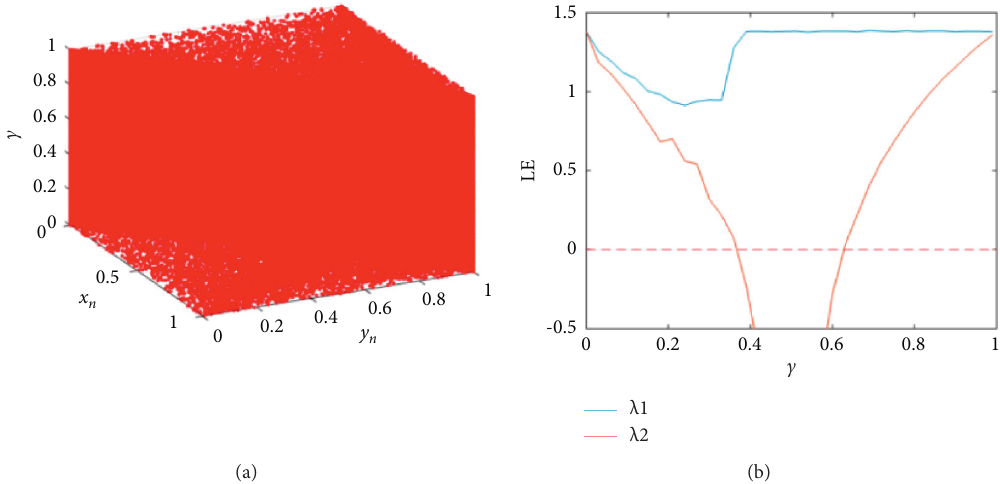
Figure 2: 2D bifurcation diagram and LE diagram of 2D-LSCM: (a) 2D bifurcation diagram; (b) LE diagram versus parameter c